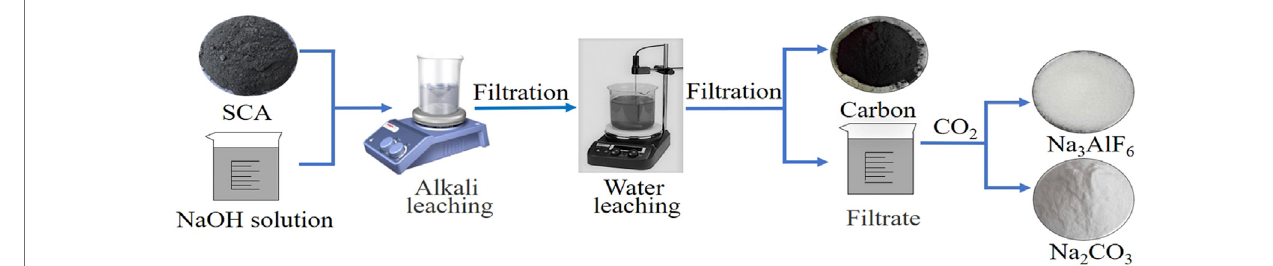
FIGURE 9 | SCA treatment via alkali leaching.